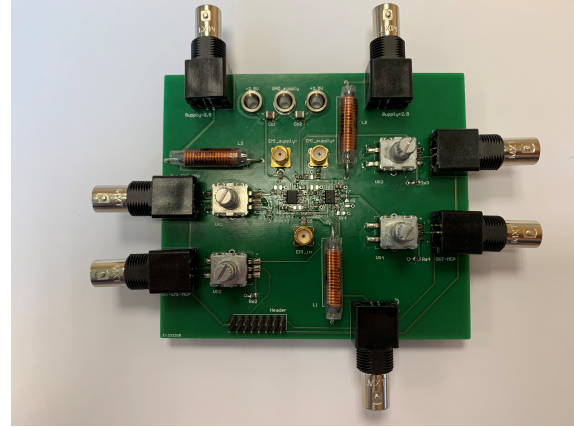
Figure 4. Photograph of the fabricated EMI test PCB.